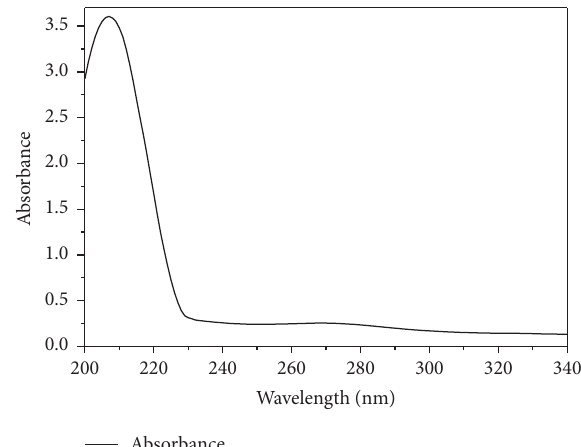
Figure 1: UV-Vis absorption spectrum of HAp NPs synthesized using aqueous extract of M. longifolium leaf at room temperature.